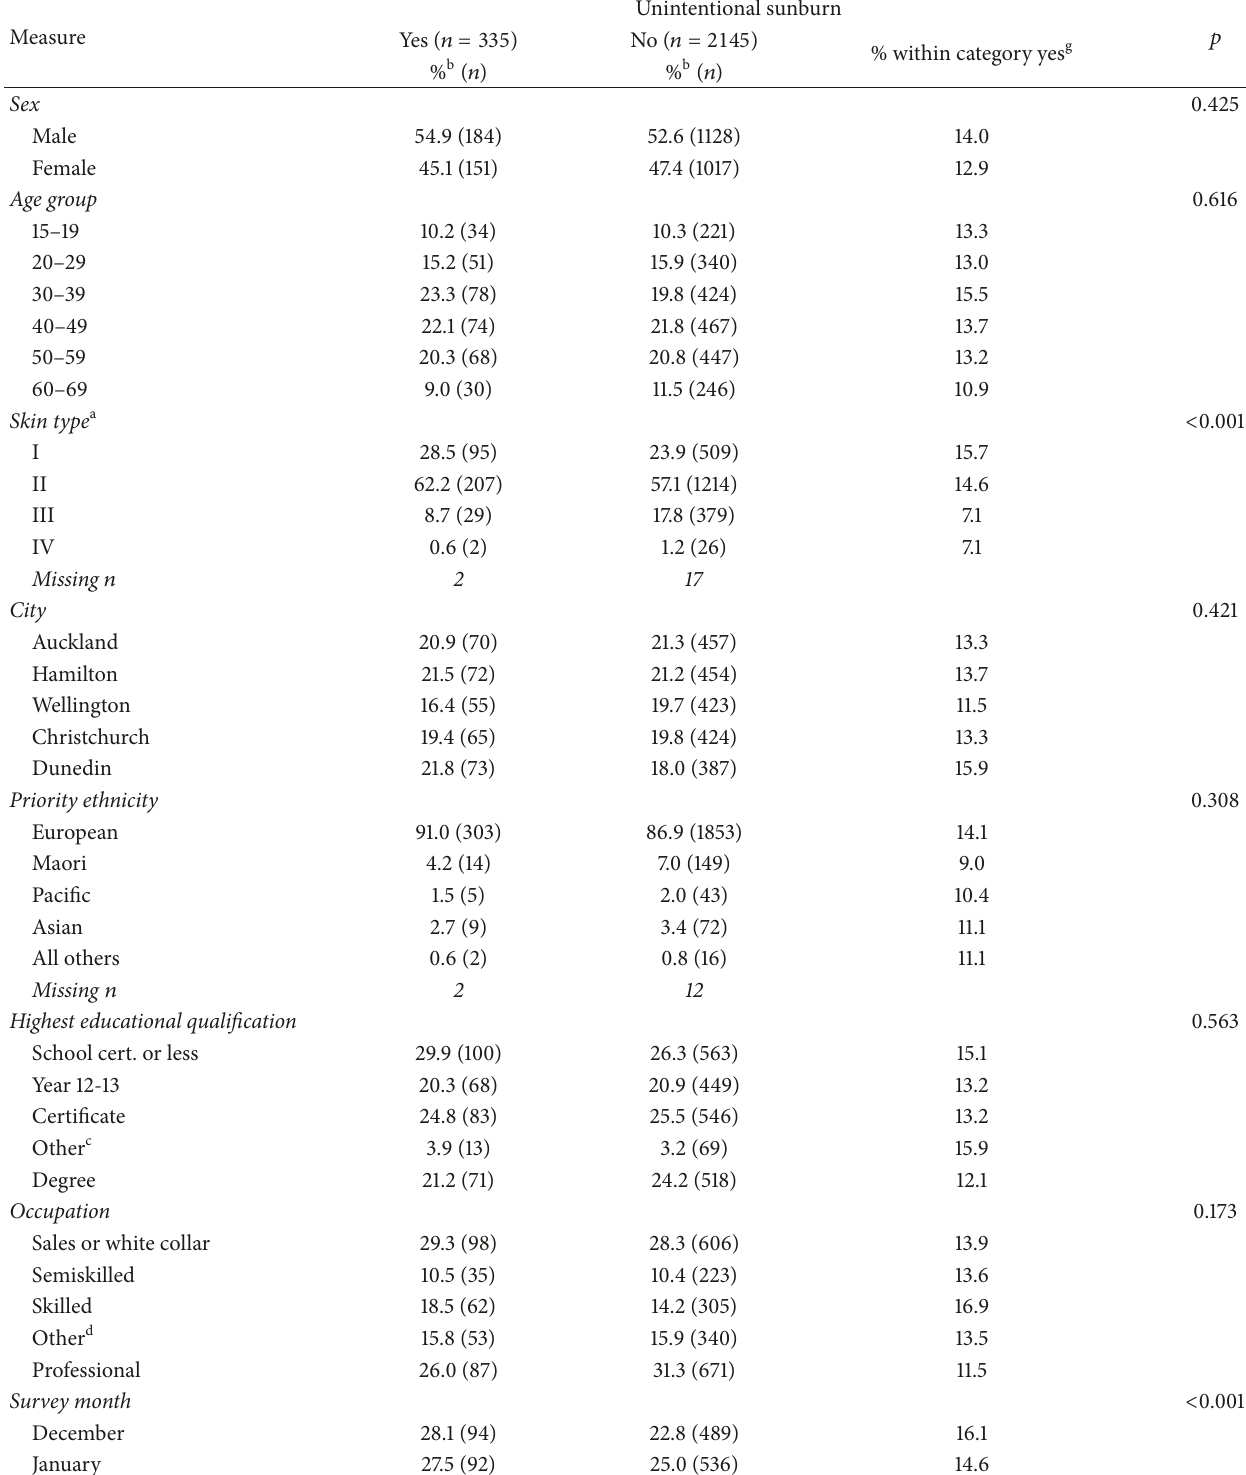
Table 1: Respondent demographic, survey year, and weather characteristics for those sunburned unintentionally and those not sunburned (aside from survey year these are pooled over survey years 1999/00 to